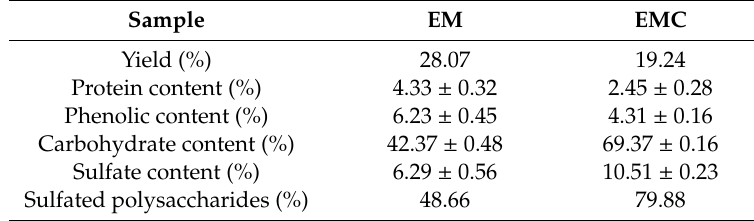
Table 2. Chemical composition of EM and EMC obtained from E. maxima